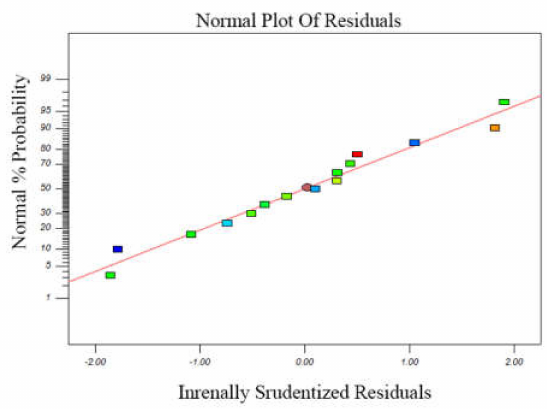
Figure 12. The normal plot of residuals of thickness.